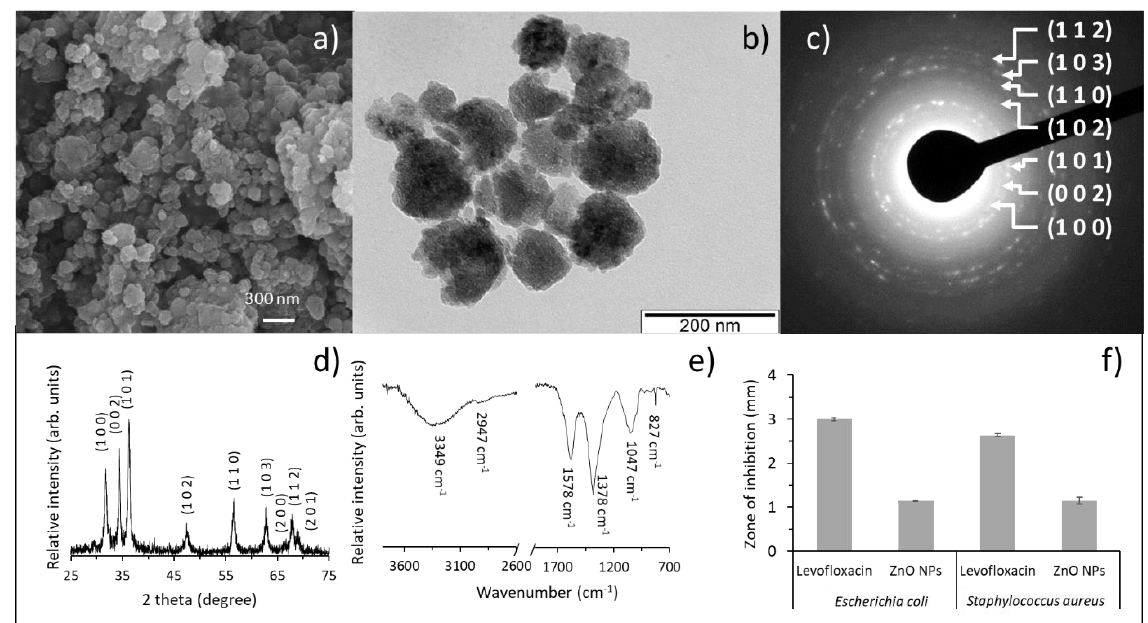
Figure 1. Green-synthesized ZnO nanoparticles using the peel extract of apple var. Golden, ( a ) scanning electron microscopy (SEM) and ( b ) transmission electron microscopy (TEM) images, with ( c ) the corresponding electron diffraction pattern (SAED), ( d ) X-ray diffraction (XRD) diffractogram with the crystallographic planes identified according with JCPDS data card 036-1451, ( e ) attenuated total reflection—Fourier transform infrared (ATR-FTIR) spectrum, and ( f ) antibacterial activity against Escherichia coli and Staphylococcus aureus .